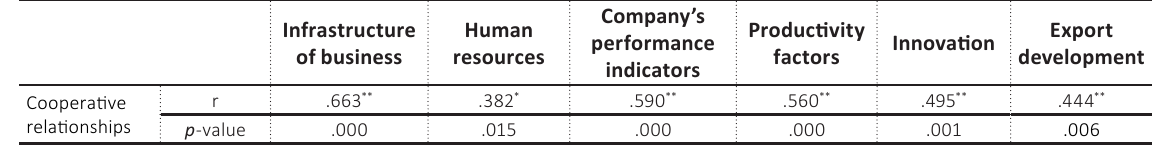
Table 1. Correlations between the derivative